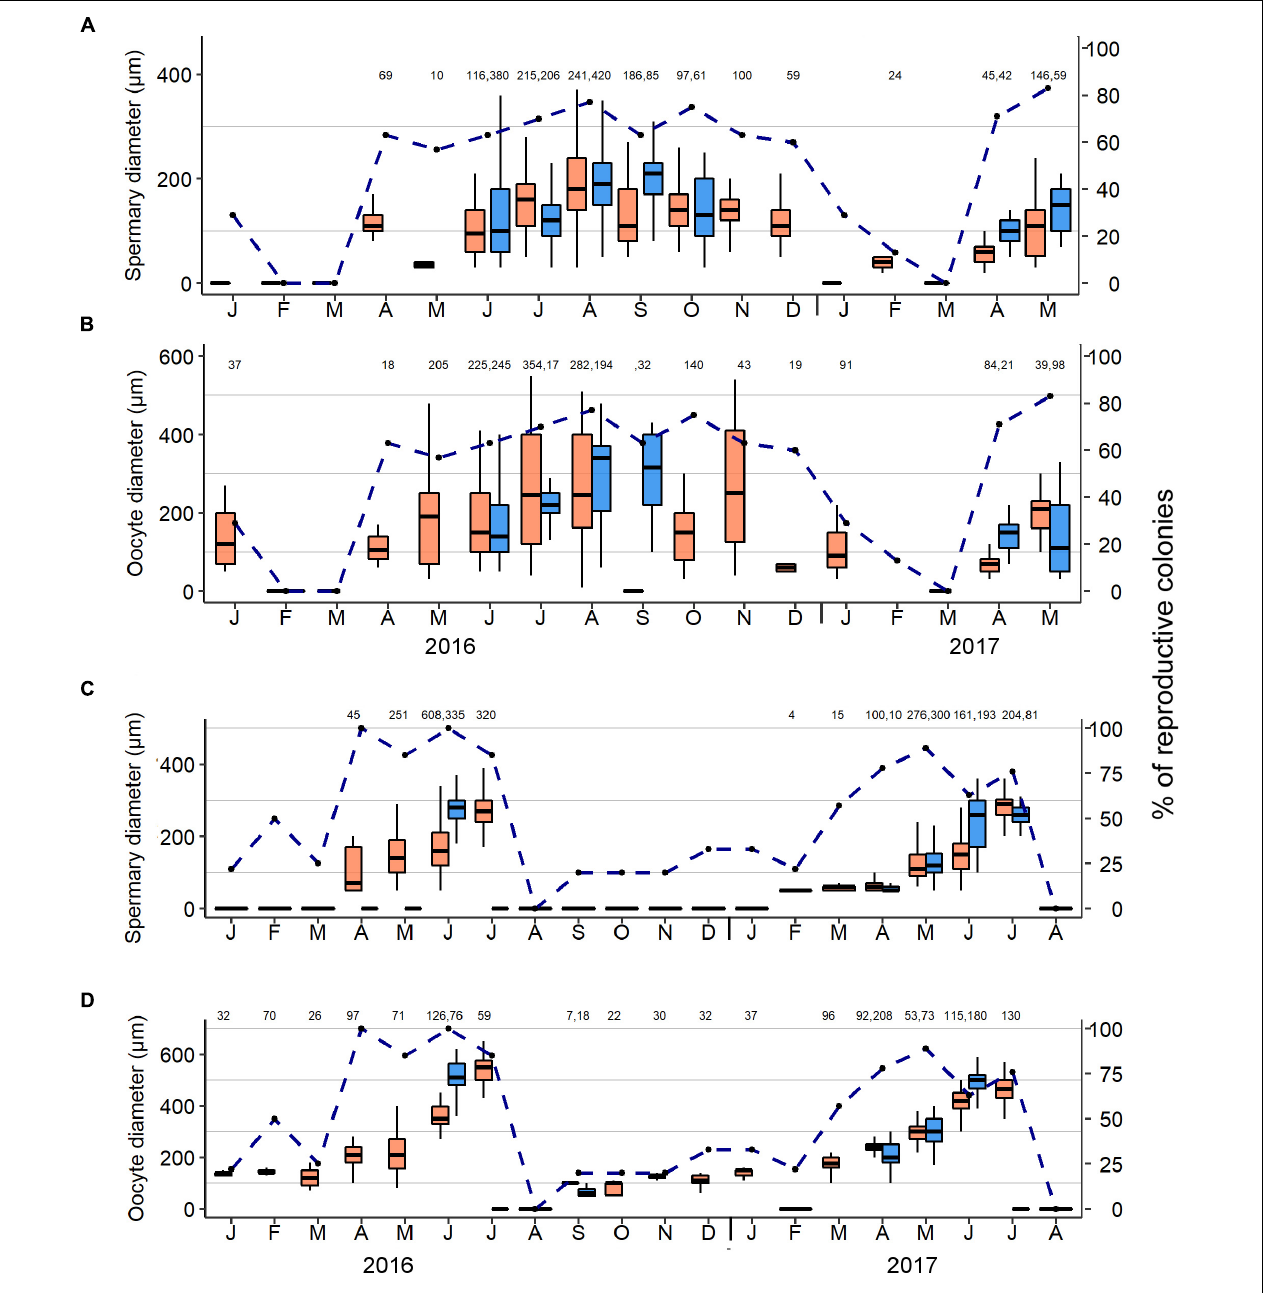
FIGURE 4 | Monthly average diameter of gonads of upper mesophotic (in orange) and shallow-water (in blue) octocorals during January 2016–August 2017: Ovabunda spp. (A) Spermaries and (B) Oocytes, and Rhytisma fulvum fulvum (C) Spermaries and (D) Oocytes. Box limits represent 25th and 75th percentiles, whiskers span upper and lower limits of data, horizontal lines within boxplots represent medians, and above x-axis number of gonads measured each month. Dashed line represents percentage of reproductive colonies of each